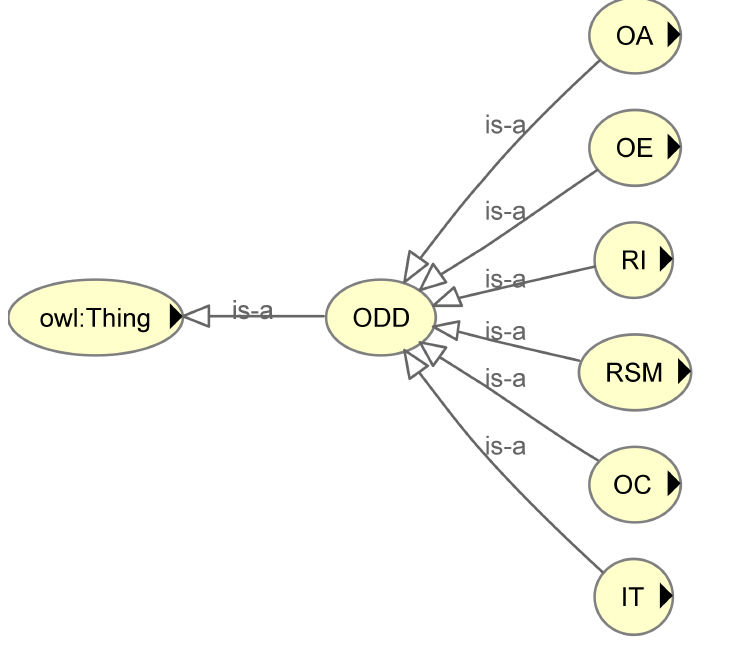
Figure 4. Operational design domain structure of the high-speed railway ATO system. OA, operation area; OE, operating environment; RI, railway infrastructure; RSM, related system member; OC, operational constraint; IT, information